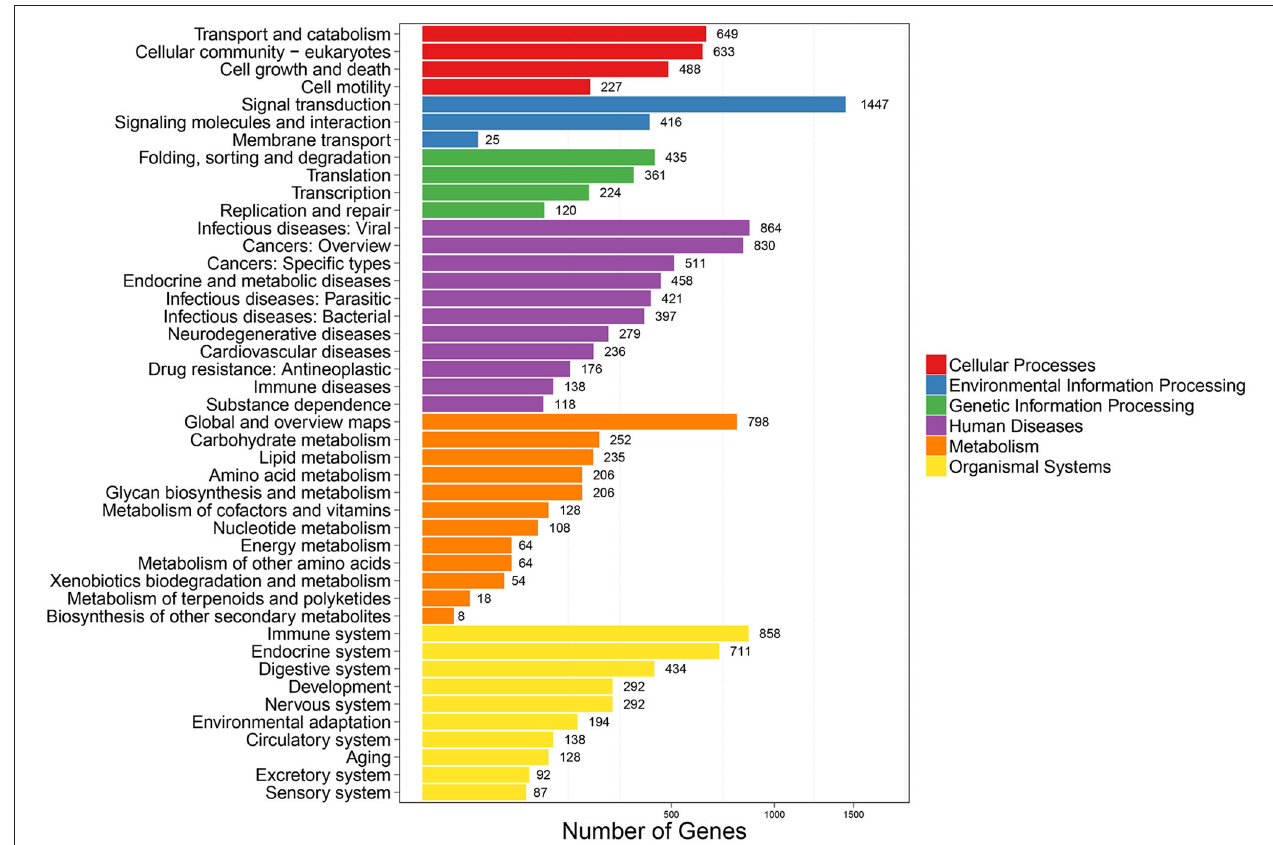
FIGURE 5 | KEGG pathway enrichment analysis of DE-miRNA target genes. The number of DEGs are shown on the X axis, while the KEGG pathway terms are shown on the Y axis. All second pathway terms are grouped in the following top pathway terms, as indicated by different